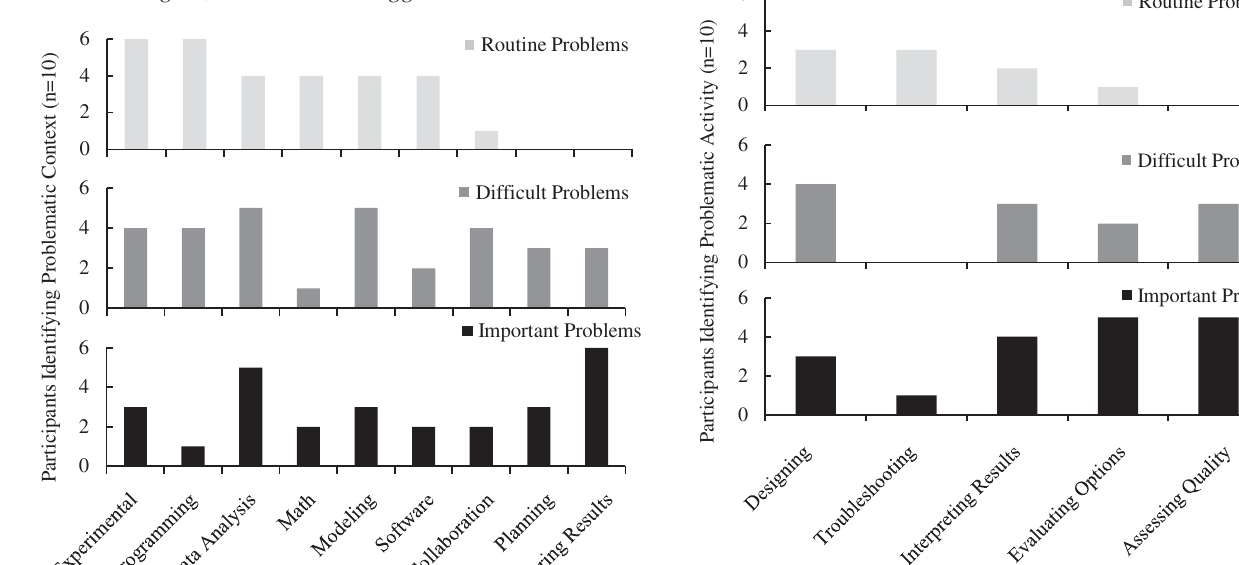
FIG. 2. Context for problems in Ph.D.-level research.